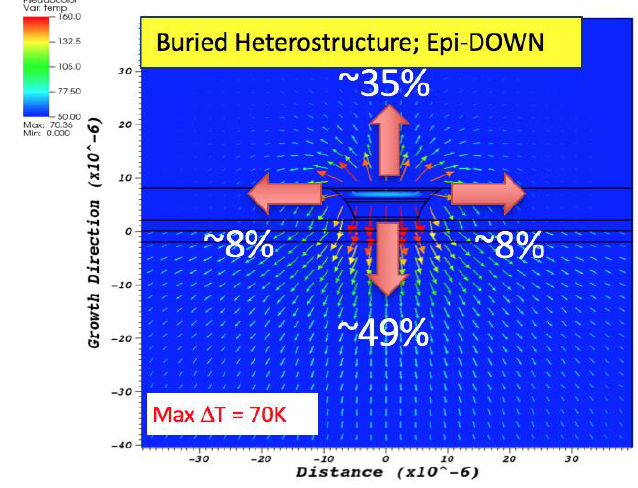
Figure 12. Heat flux configuration for BH epi-layer down mounted QCL.